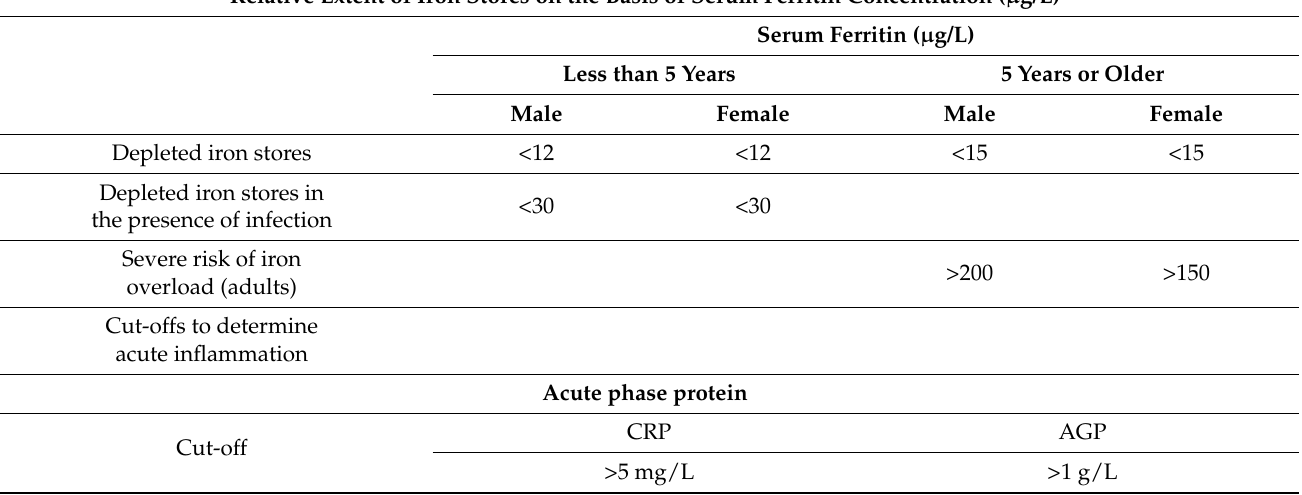
Table 1. Cut-off of Iron and C-reactive